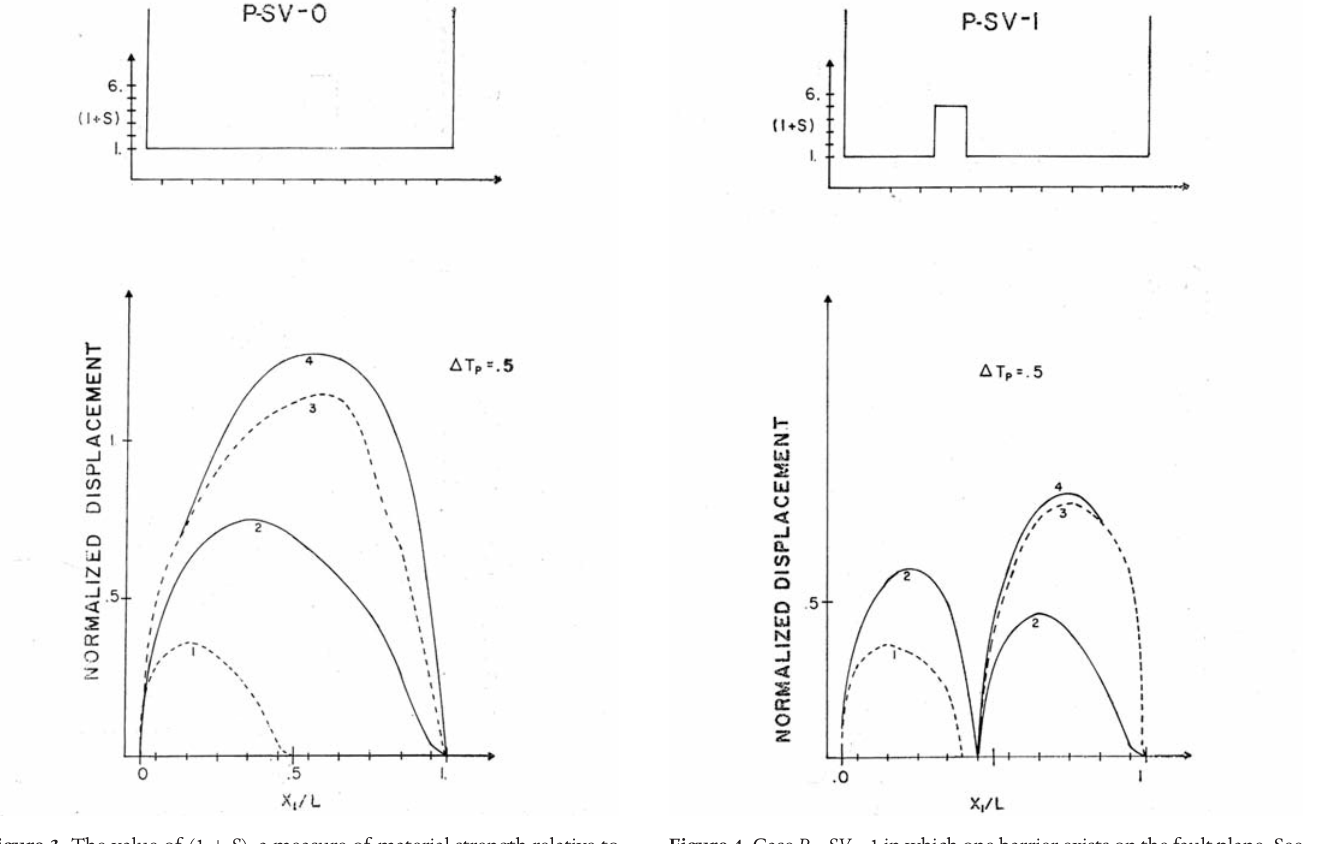
Figure 3. The value of (1 + S ), a measure of material strength relative to Figure 4. Case P – SV – 1 in which one barrier exists on the fault plane. See along the path of tectonic stress is shown as a function of distance, x Figure 3 legend for details. The crack tip skips the barrier without breaking 1 rupture propagation on the top of the figure. This is the case P – SV – 0 in it. Reproduced from Das and Aki which no barriers exist on the fault plane. At the bottom, snap shots of ( x , o , t ) are the parallel component displacement on the crack surface u 1 1 . u is normalized by the factor L ( τ – τ )/ μ and shown as a function of x f 1 1 0 the number attached to each curve indicates time t measured in the unit of 0.5 L / α , where L is the length of the fault, α . is the compressional wave is the initial tectonic stress, and τ is the dynamic velocity, μ is the rigidity, τ f 0 function of the fault plane. Reproduced from Das and Aki [1977].